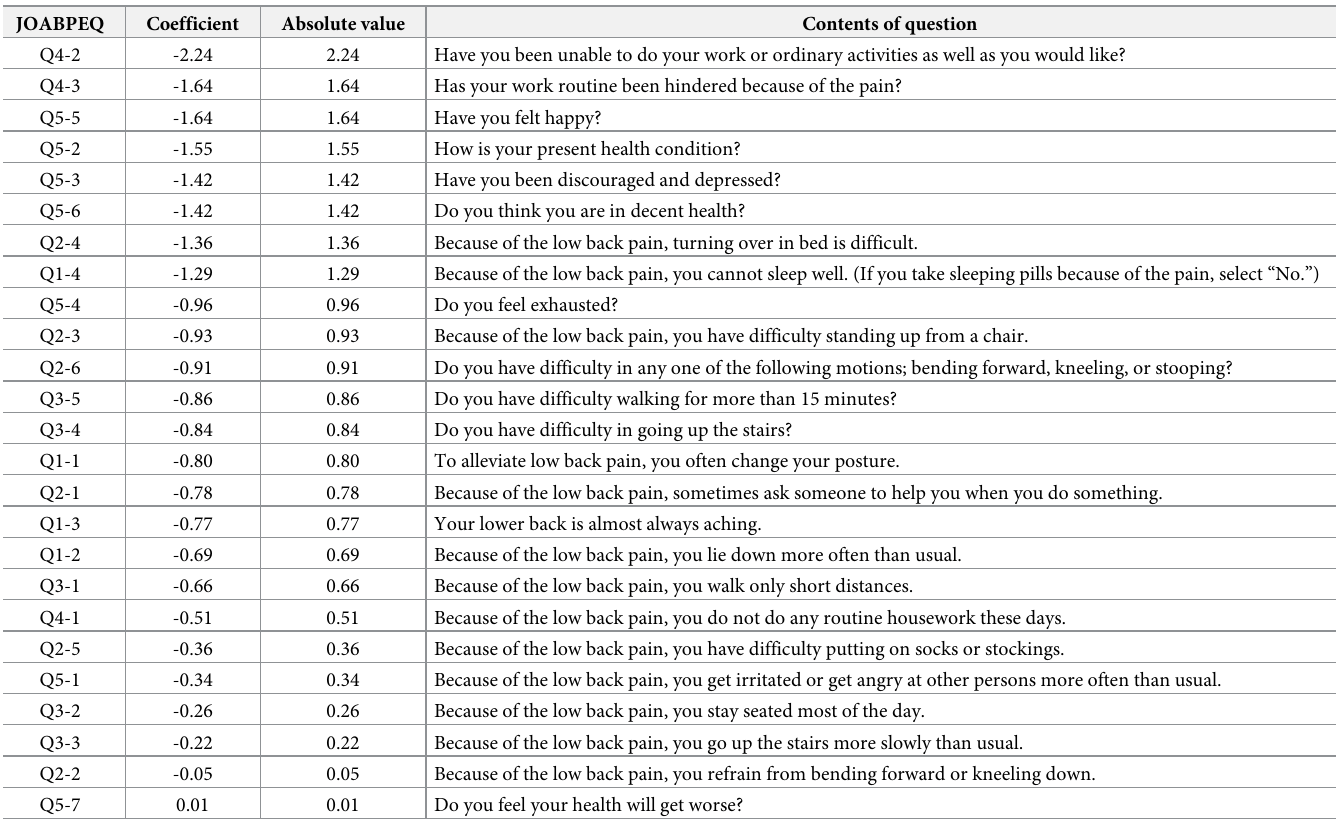
Table 3. Regression coefficients of each JOABPEQ item for the degree of lower limb pain (in descending order of absolute value). JOABPEQ Coefficient Absolute